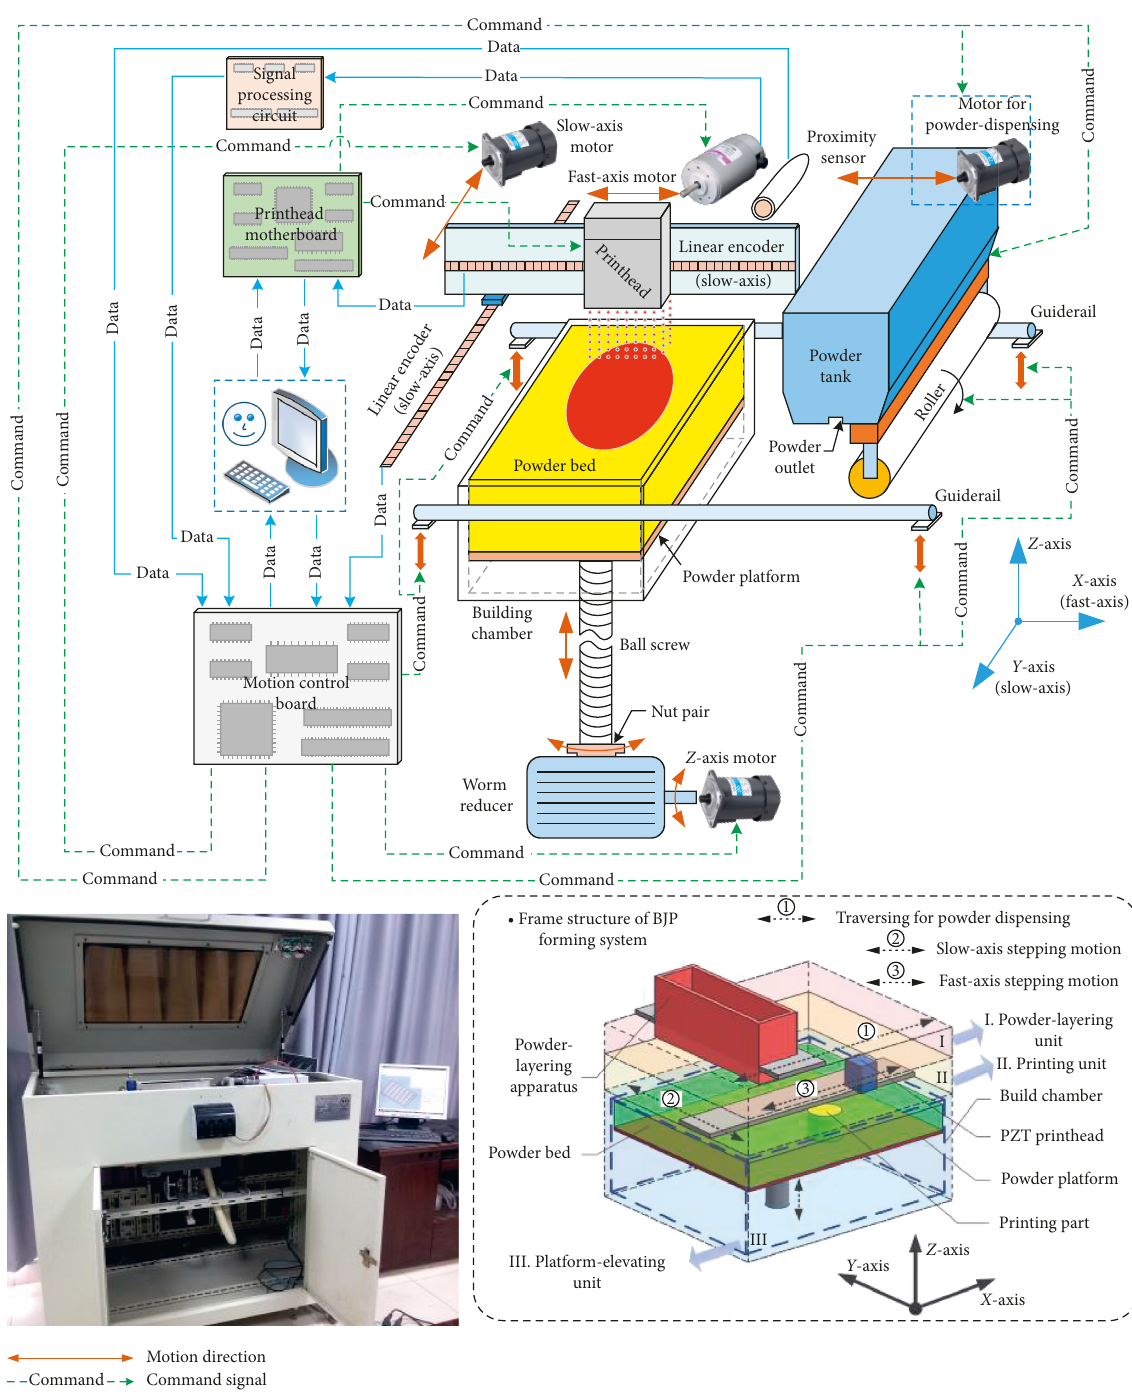
Figure 1: In-house developed BJP forming machine